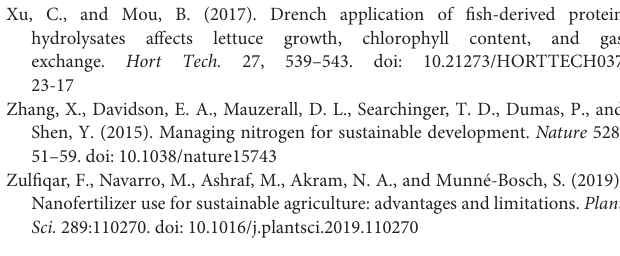
Nanofertilizer use for sustainable agriculture: advantages and limitations. Plant Sci. 289:110270. doi: 10.1016/j.plantsci.2019.110270